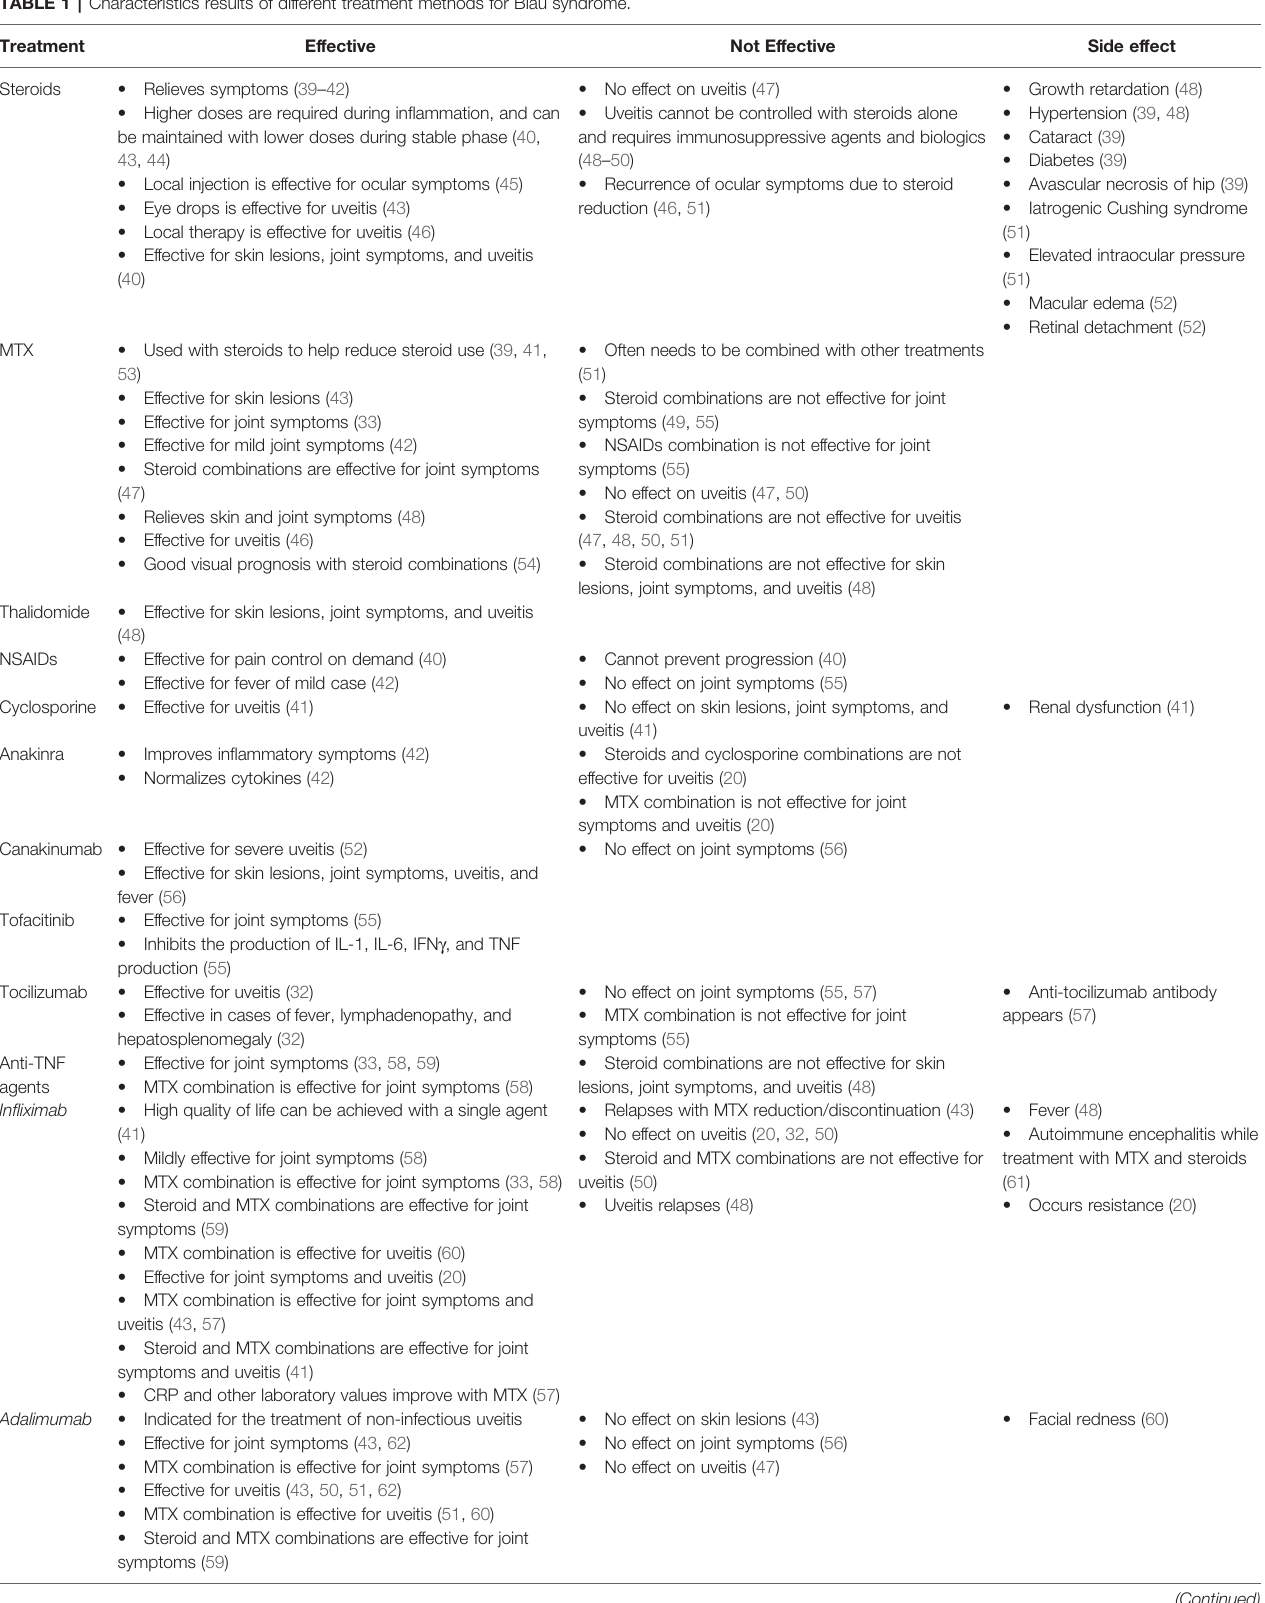
TABLE 1 | Characteristics results of different treatment methods for Blau